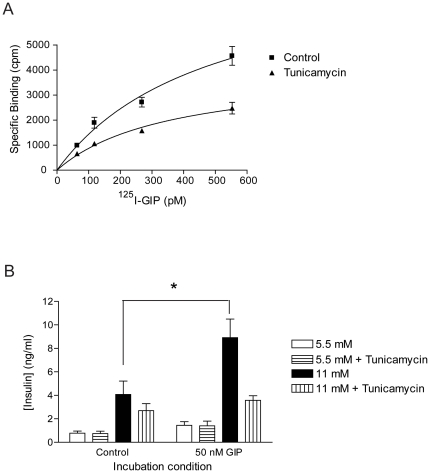
N-glycosylation regulates GIP receptor number and GIP-potentiated insulin secretion in INS-1 cells.(A) Plot of specific binding versus concentration of 125I-GIP saturation carried out in INS-1 cells with or without 1 µg/ml tunicamycin. Data were fitted with a non-linear regression equation assuming a single binding site (GraphPad Prism). Control cells expressed an average of 2443±400 GIP receptors on the cell surface (Kd 455±50 pM), whereas tunicamycin-treated cells expressed 760±70 GIP receptors on the cell surface (Kd 345±100 pM). (B) Plot of insulin release in response to glucose and/or GIP, from INS-1 cells with or without 1 µg/ml tunicamycin. Data are expressed as mean ± SEM, n = 4 separate experiments. Asterisk indicates a significant increase in insulin release compared to basal conditions without addition of 50 nM GIP (P<0.05), as determined using two-way ANOVA followed by Bonferroni post-tests.